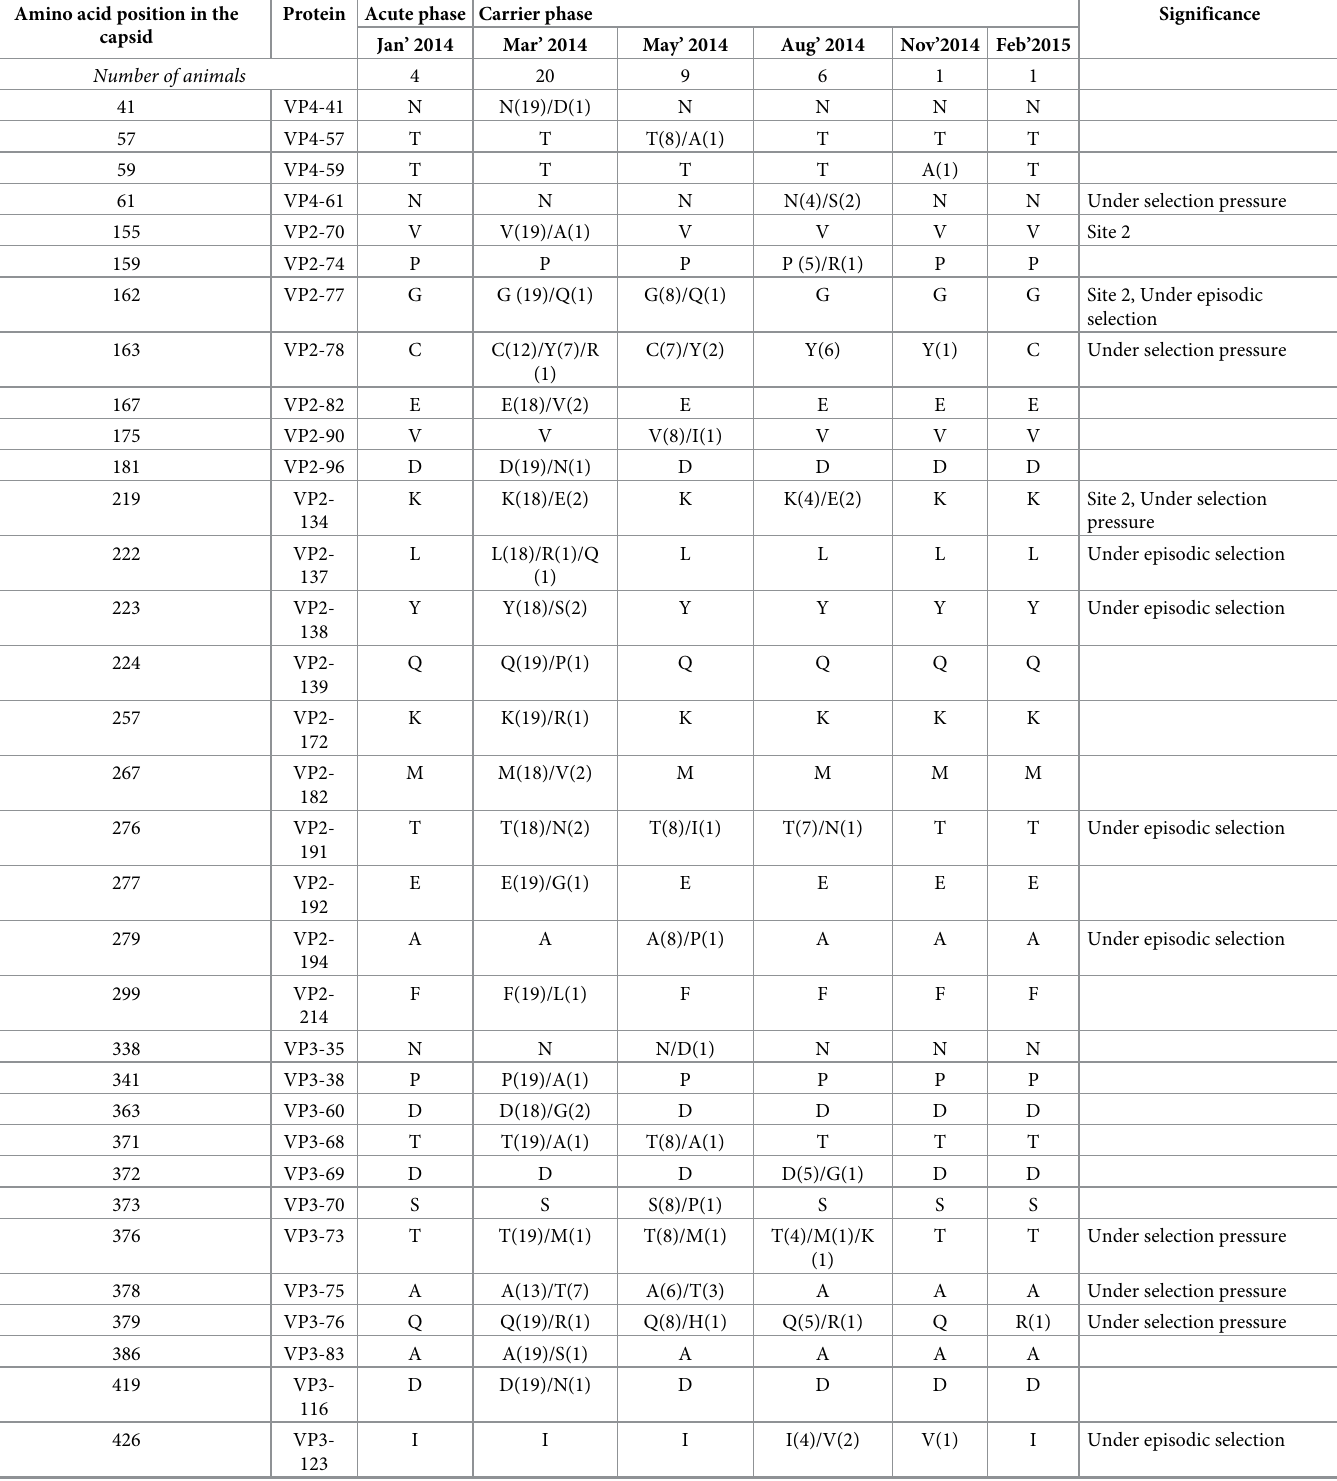
Table 2. Amino acid variations in the capsid coding region of carrier virus isolates compared to the outbreak virus collected in January 2014. Number of virus iso- lates in which the changes occurred is in parentheses . Amino acid position in the